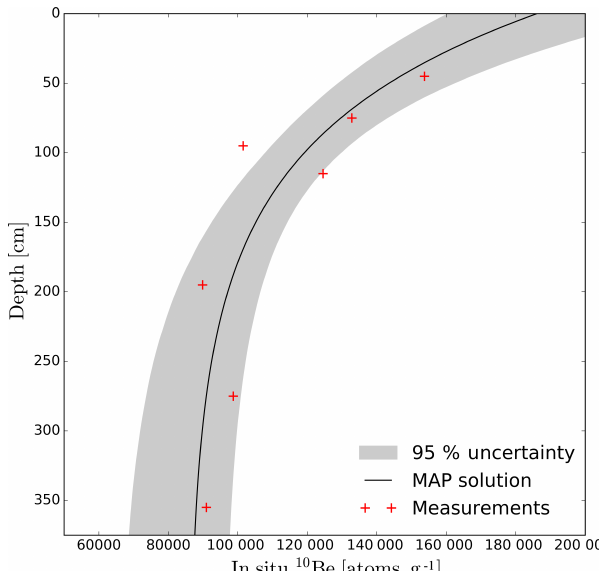
Figure 9. 95% predictive uncertainty interval (gray area) and asso- ciated MAP prediction (black line) derived using our approach. The red crosses represent the seven measurement data points used in the inversion. Depth is given in absolute